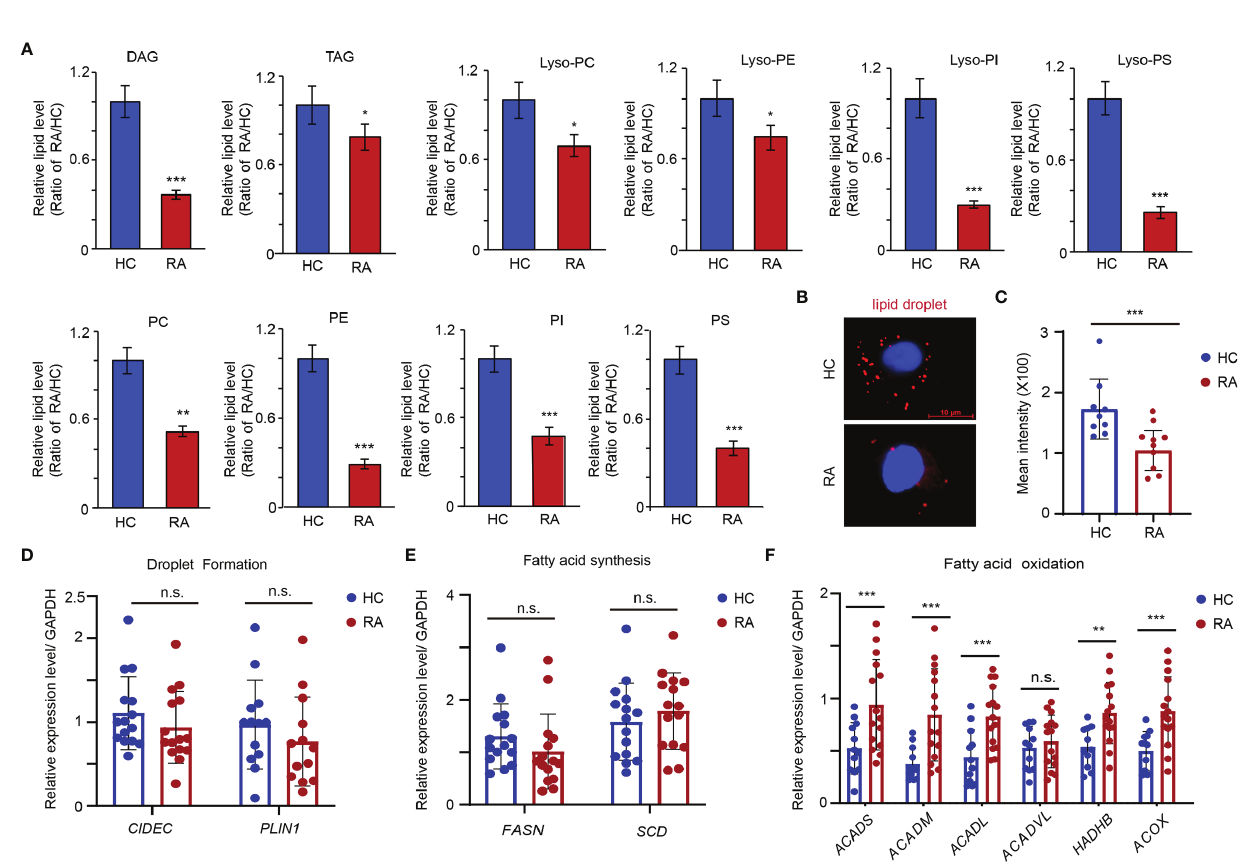
FIGURE 1 | Enhanced Fatty acid oxidation in the precursor of osteoclasts of RA patients. CD14 + monocytes were isolated from RA patients and HCs. (A) Metabolite analysis of lipid including diacylglycerol (DAG), triacylglycerols (TAG), phosphatidylcholine (PC), phophatidylethanolamine (PE), phosphatidylnositol (PI), phosphatidylserine (PS), lyso-PC, lyso-PE, lyso-PI and lyso-PS content in the monocytes from HC (n = 3) and RA patients (n = 3). The results shown as the ratio of lipid levels of RA/lipid levels of HC. (B, C) Neutral lipid droplet were stained with Nile red and quanti fi ed with software of image J at (C) . (D) Transcription level of FSP27 and PLIN1 expression was quanti fi ed by qPCR in monocytes from 15 RA patients and 15 HCs. The results from 3 independent experiments. (E) Transcription level of FASN and SCD5 expression was quanti fi ed by qPCR in monocytes from 15 RA patients and 15 HCs. The results from 3 independent experiments. (F) Transcription level of ACADS , ACADM , ACADL , ACADVL , HADHB , and ACOX were quanti fi ed by qPCR in monocytes from 15 RA patients and 15 HCs. The results from 3 independent experiments. All data was presented as the mean ± SEM. * P < 0.05; ** P < 0.01; *** P < 0.001; n.s. no signi fi